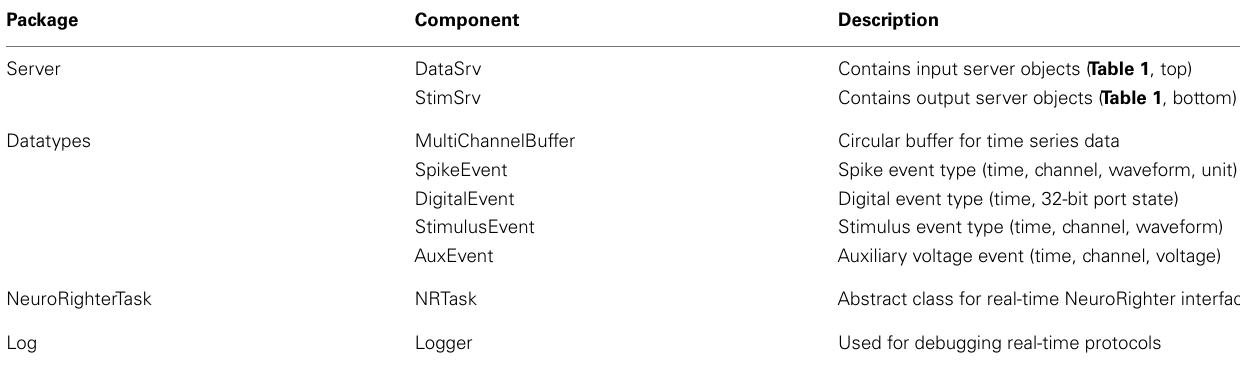
Table 2 | Packages included with NeuroRighter’s